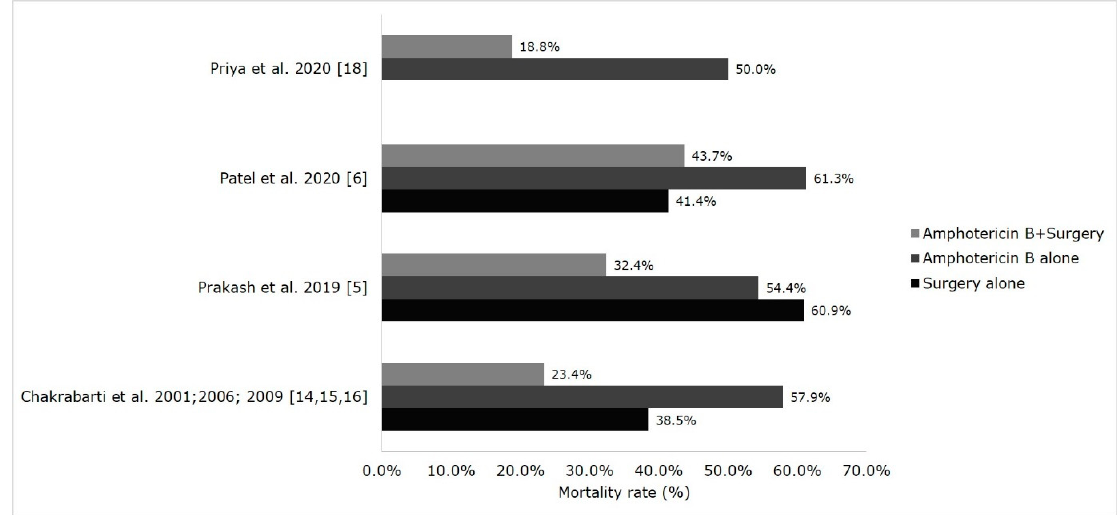
Figure 4. Modes of therapy and mortality rate in Indian population. The data shown in figure for the study Patel et